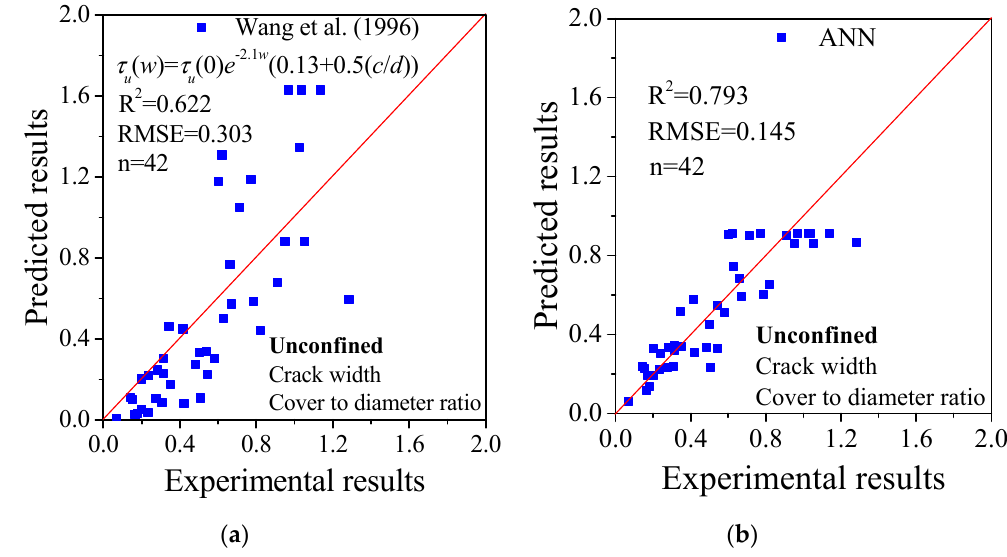
Figure 8. Comparison between the existing analytical models and ANN method considering both crack width and cover-to-diameter ratio as inputs for specimens without stirrups (unconfined) (note τ u ( w ) is the bond strength of specimen with crack width w , τ u (0) is the bond strength of specimen without corrosion damage, w is the crack width on the surface of specimen and c / d is the cover-to-diameter ratio): ( a ) Wang et al. (1996) [55]; ( b ) ANN.